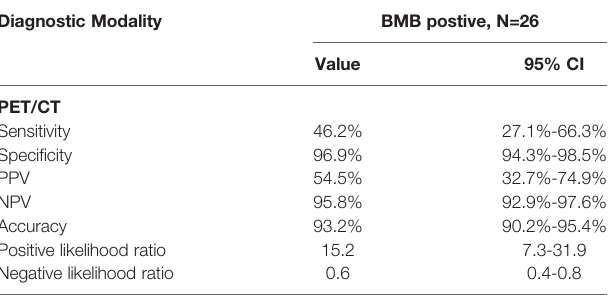
TABLE 3 | Comparison of the diagnostic performance of PET/CT in bone marrow involvement. Diagnostic Modality